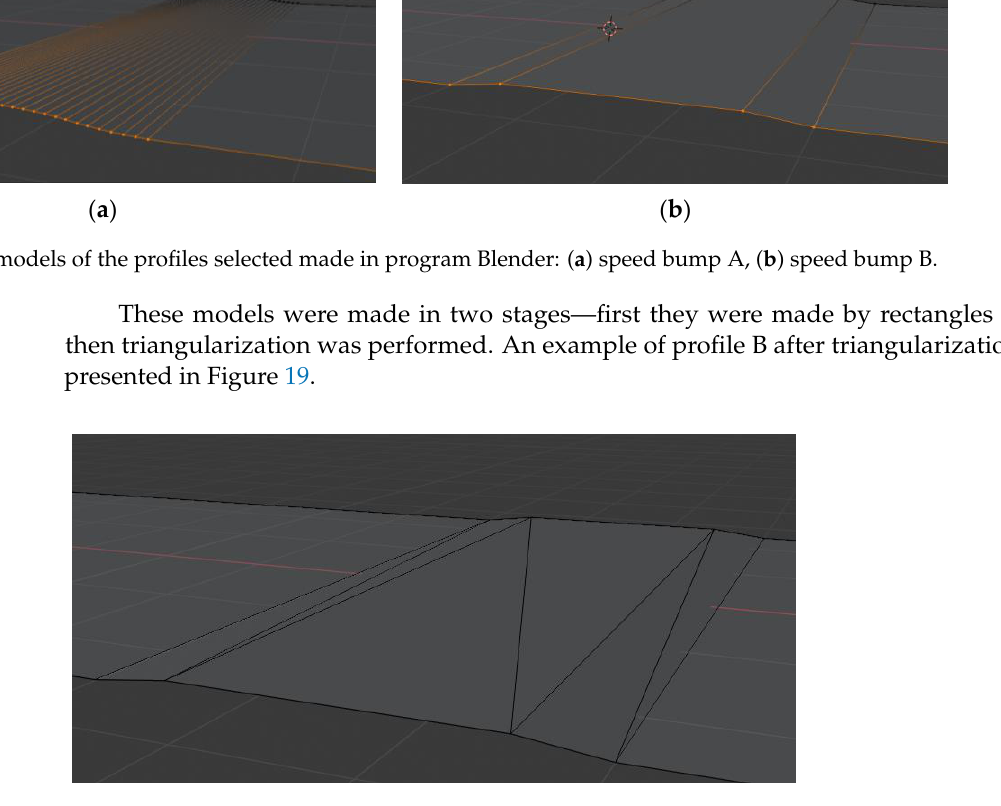
Figure 17. Characteristic of the profiles selected, respectively for: ( a ) speed bump A, ( b ) speed bump B. The dots presented in these diagrams symbolize points of the road surface division during its modeling in program Blender [26], Figure 18.